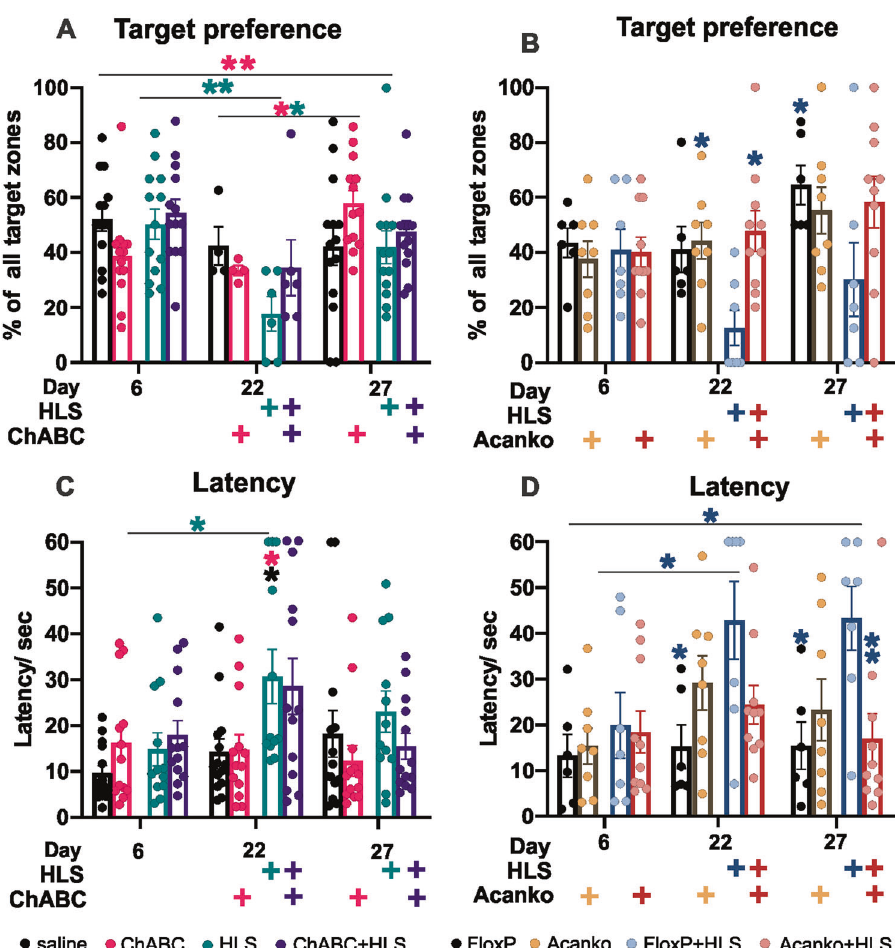
Fig. 5 Probe test with target platform removed, comparing the 6th and 22nd and 27th days, assaying memory at the end of pre-training, after HLS and after relearning. Target preference and latency are shown here, other measures in Fig. S5. There are no signi fi cant differences between groups after the fi rst training session, but HLS causes loss of target preference and increased latency in all but the Acan KO group A – D . (TW-RM-ANOVA, Preference, Group F (3,27) = 5.282 p = 0.0054, FloxP HLS vs. FloxP q = 4.651 p = 0.014, FloxP HLS vs. Acan KO HLS q = 5.028 p = 0.0073, Acan KO vs. Acan KO HLS q = 0.7804 p = 0.945; Latency, Group F (3, 48) = 4.269 p = 0.0094, HLS vs. saline q = 4.130 p = 0.0264, ChABC HLS vs. ChABC q = 2.890 p = 0.187; Latency, group, F (3, 27) = 5.817 p = 0.0033, FloxP HLS vs. FloxP q = 5.526 p = 0.003, FloxP HLS vs. Acan KO HLS q = 4.651 p = 0.014). All groups show some relearning (statistics Tables S7 and S8 in attachments). Signi fi cance * p < 0.05, ** p < 0.01, *** p < 0.001. (Fig. 4 saline n = 13, HLS n = 14, ChABC n = 13, ChABC HLS n = 14, FloxP n = 8, FloxP HLS n = 6, Acan KO n = 6, Acan KO HLS n = 10